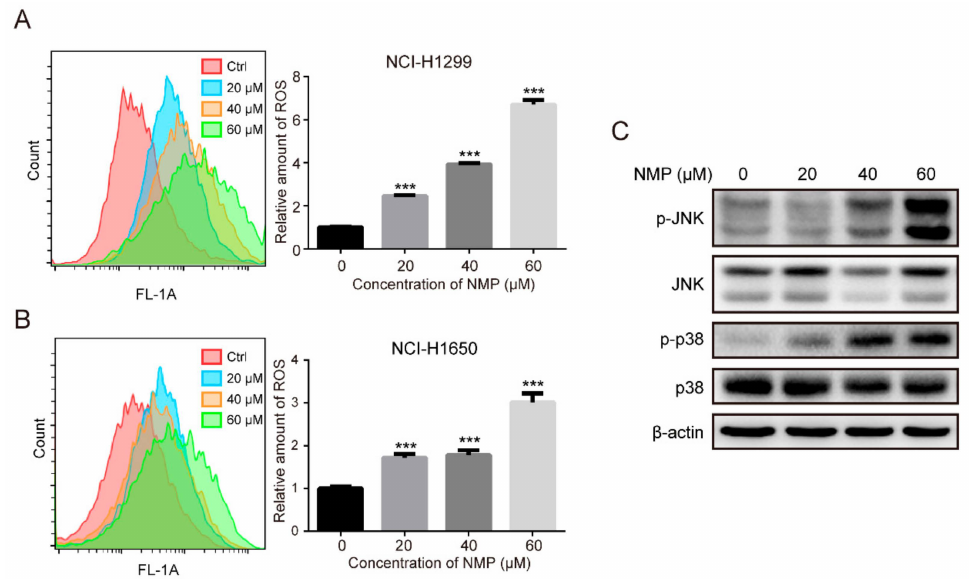
Figure 4. NMP induced ROS accumulation and activated MAPK pathways. ( A , B ) Flow cytometry analyses of intracellular ROS in NMP-treated NCI-H1299 and NCI-H1650 labeled with green DCFDA fluorescent dye. Error bars mean ± S.D. of three independent experiments; *** p < 0.001, compared to the control group. ( C ) Western blot assay for MAPK pathways in NMP-treated NCI-H1299 cells. 2.5. ROS Clearance Reversed the Activation of JNK / p38 and Attenuated NMP-Induced